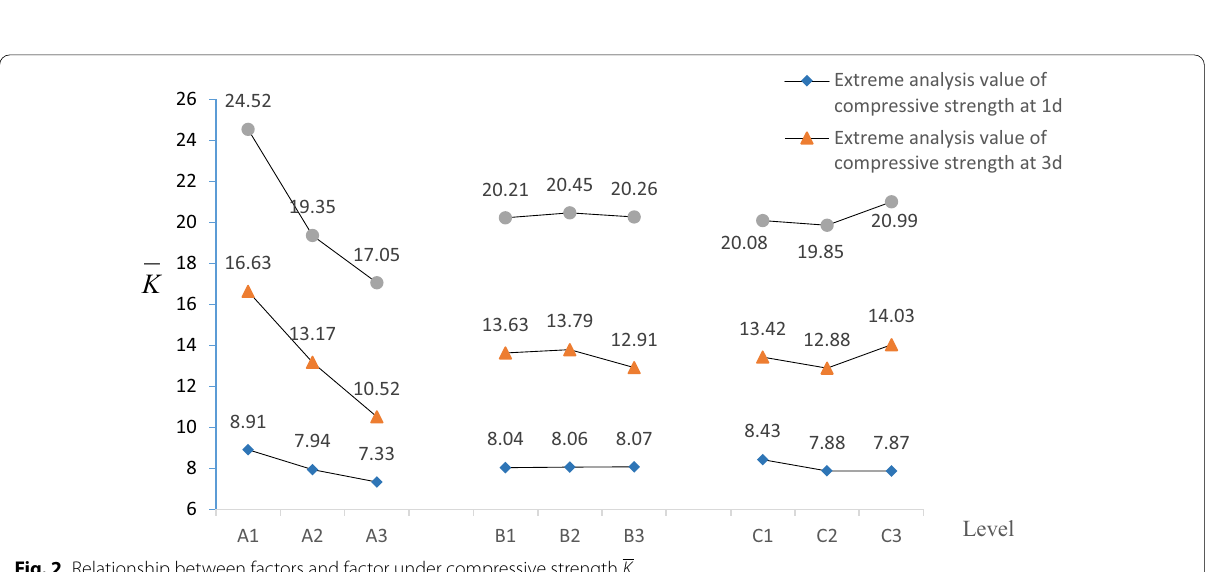
Fig. 2 Relationship between factors and factor under compressive strength K